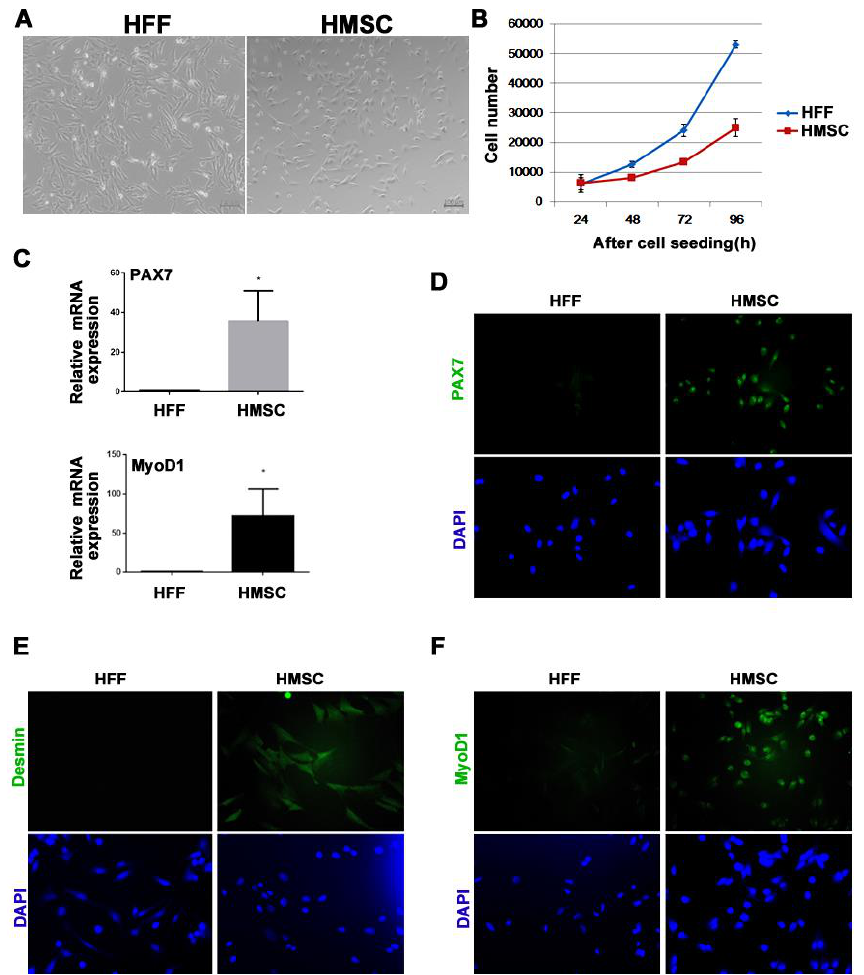
Figure 1. HMSC characterization. ( A ) Morphology of HFF and HMSC in vitro . ( B ) Proliferation curves ( p < 0.05) of HFF (blue line) and HMSC (red line). ( C ) qPCR determination of Pax7 and MyoD1 mRNA expression in HFF and HMSC * p < 0.05. ( D – F ) Immunofluorescence results of Pax7 , Desmin , and MyoD1 in HFF and HMSC.